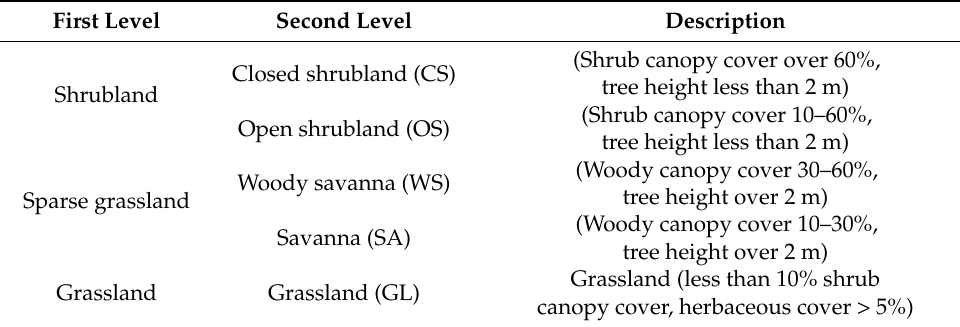
Figure 2. Flow chart of this paper’s grassland ecosystem service value evaluation. ESV1: organic matter production value, ESV2: promoting nutrient circulation value, ESV3: gas regulation value, ESV4: soil conservation value, ESV5: water conservation value. NPP: net primary production. DEM: digital elevation model. RUSLE: revised universal soil loss equation. GPM: Global Precipitation Measurement. Table 1. African grassland classification